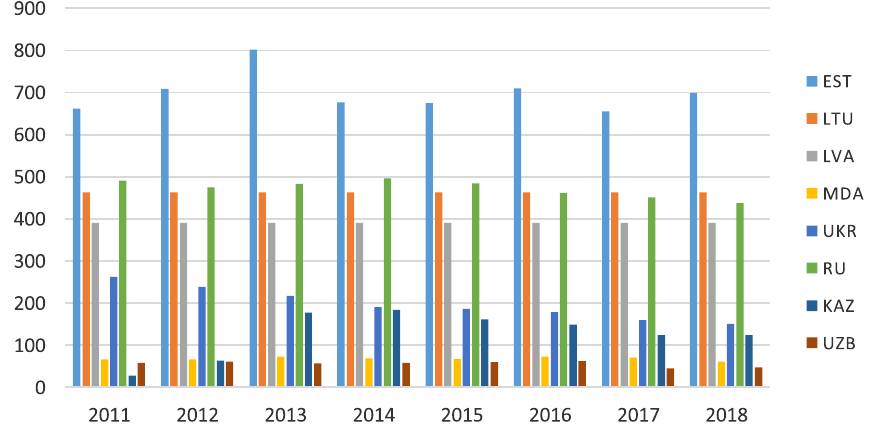
Figure 4. Technicians in R&D (per million people) in post-Soviet countries in